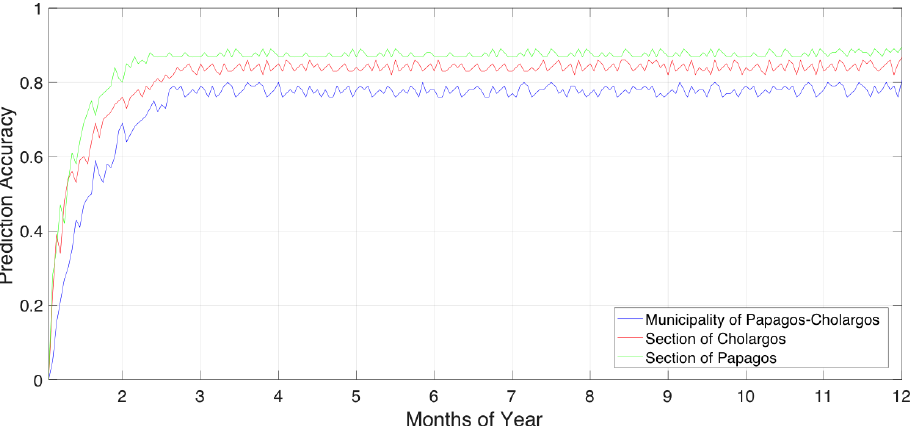
Figure 6. Prediction accuracy of municipality and municipality sections per year.